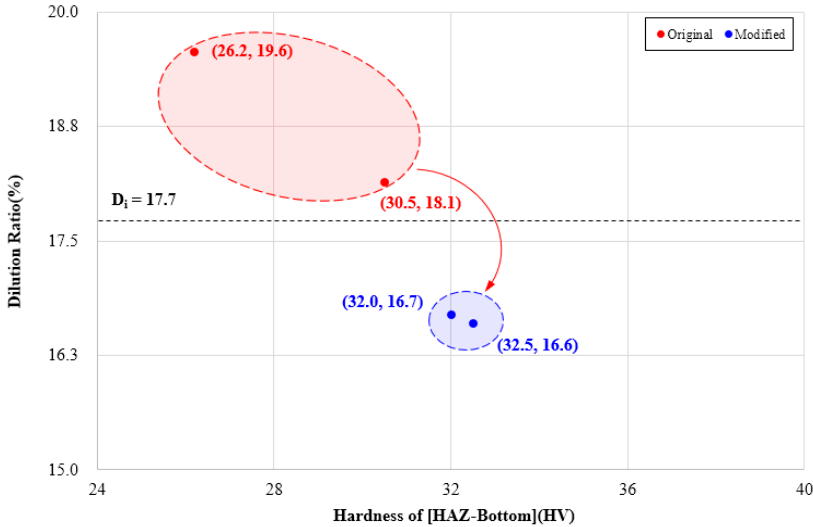
Figure 11. Weld joint hardening distributions using modified input parameters.